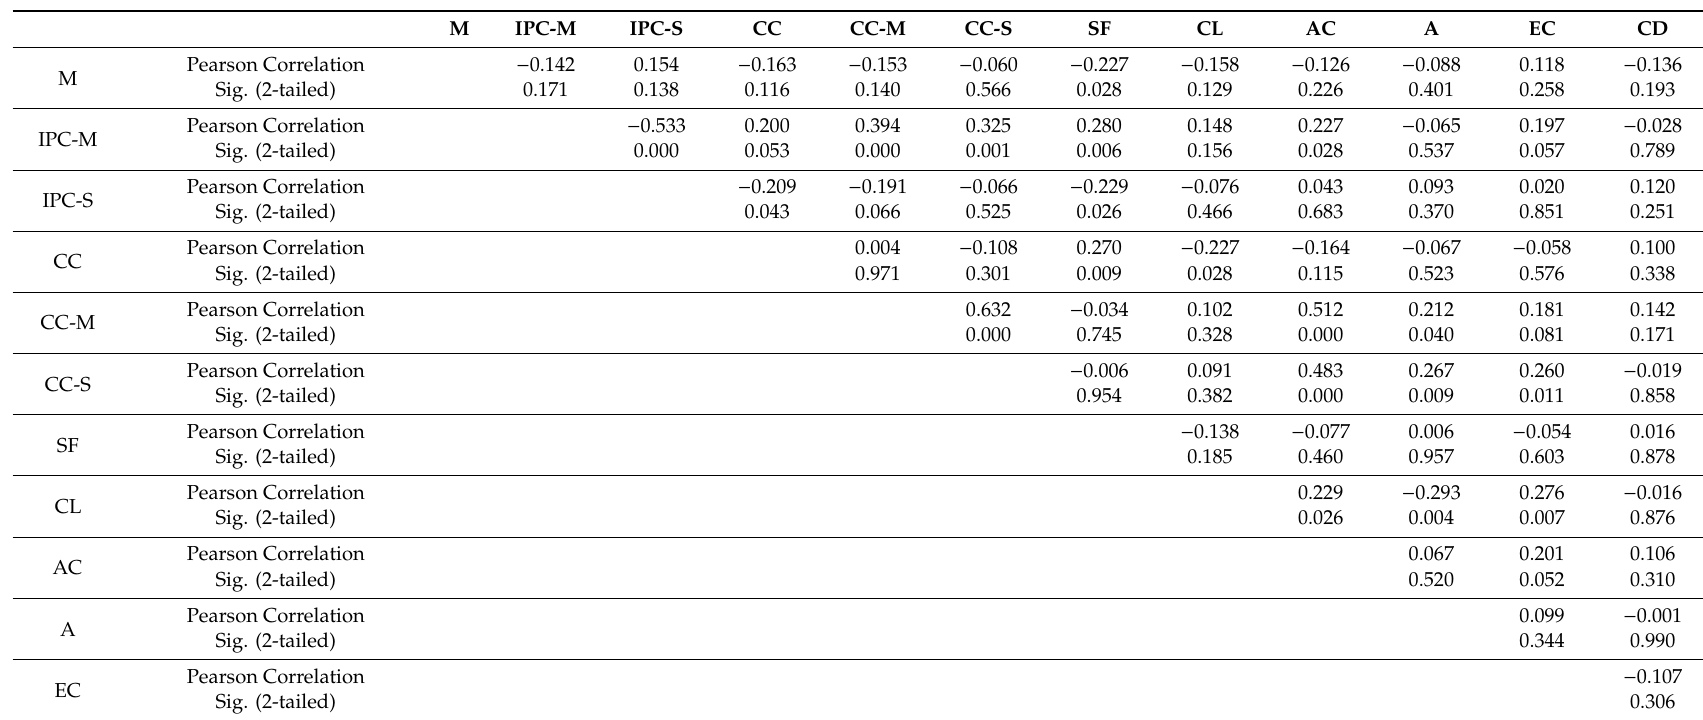
Table 4. The correlation matrix of the